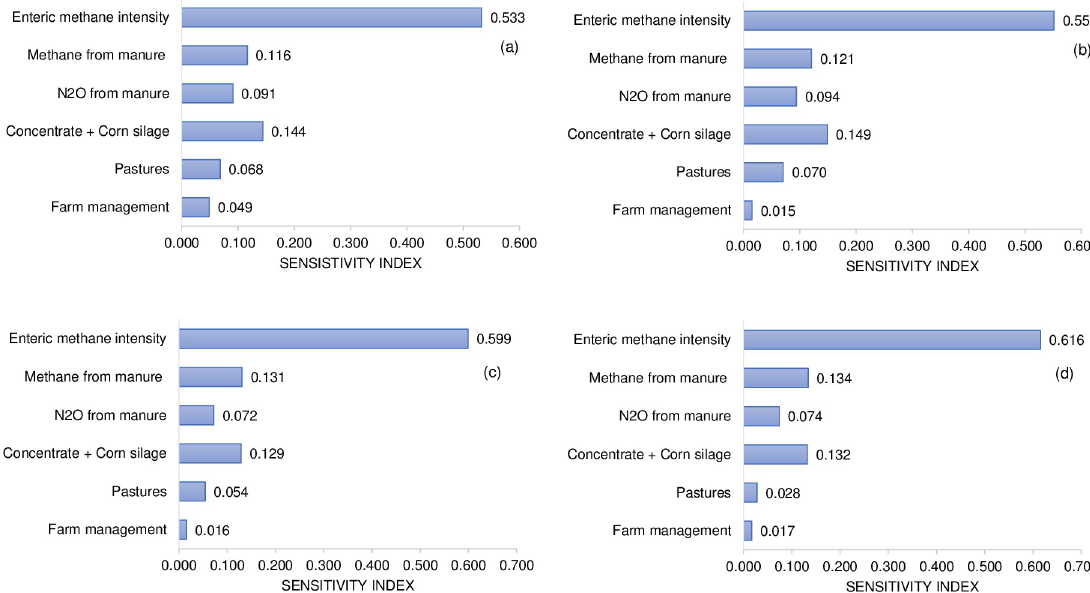
Fig 3. Sensitivity of the C footprint. Sensitivity index = percentage change in C footprint for a 10% change in the given emission source divided by 10% of. (a) N 2 O emission factors for urine and dung from IPCC [38], feed production emission factors from Table 3, production of electricity = 0.73 kg CO 2 e kWh -1 [41]. (b) N 2 O emission factors for urine and dung from IPCC [38], feed production emission factors from Table 3, production of electricity = 0.205 kg CO 2 e kWh -1 [46]; (c) N 2 O emission factors for urine and dung from local data [37], feed production EF from Table 4 without accounting sequestered CO 2 -C from perennial pasture, production of electricity = 0.205 kg CO 2 e kWh -1 [46]. (d) N 2 O emission factors for urine and dung from local data [37], feed production emission factors from Table 4 accounting sequestered CO 2 -C from perennial pasture, production of electricity = 0.205 kg CO 2 e kWh -1 [46].